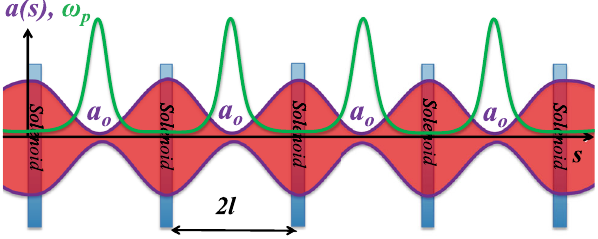
FIG. 2. A sketch of four focusing cells with periodic modu- lations of beam envelope, a ð s Þ , and the plasma frequency, ω . p Beam envelope has waists, a , in the middle of each cell where o plasma frequency peaks. Scales are attuned for illustration purposes. The waists of the beam serve as “ short focusing elements ” for the longitudinal plasma